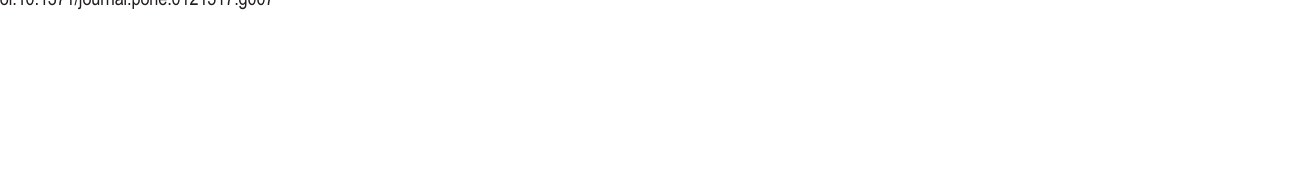
PLOS ONE | DOI:10.1371/journal.pone.0121517 April 8,